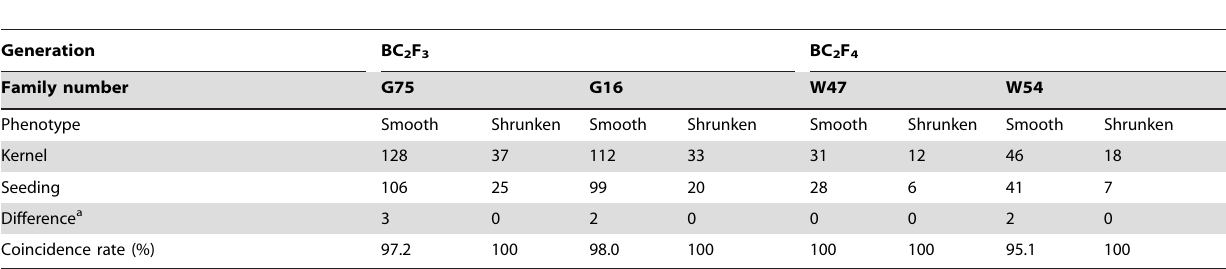
a Number of different kernels between phenotype and genotype.